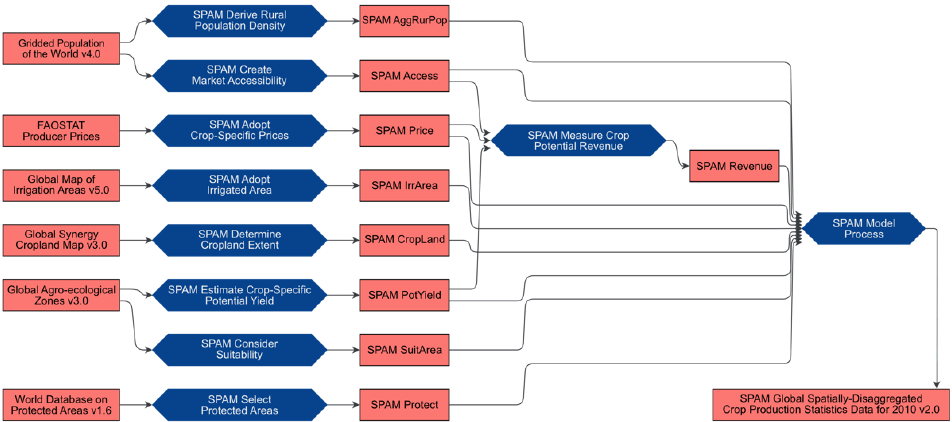
Figure 2. Simplified provenance graph of SPAM2010 data series. Red rectangles describe datasets and blue boxes describe processes.